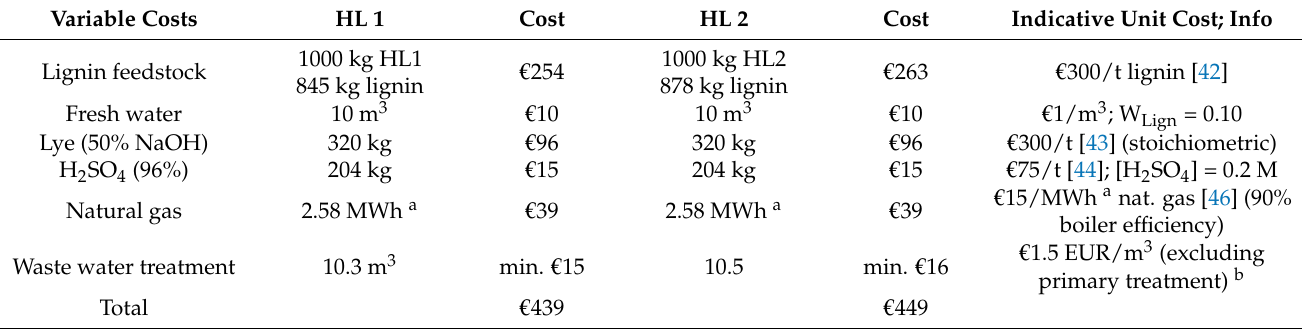
Table 3. Required input and output for the alkaline hydrolysis-acid precipitation of one metric ton hydrolysis lignin and an estimation of associated costs and